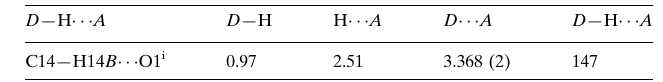
Hydrogen-bond geometry (A˚ , (cid:1)